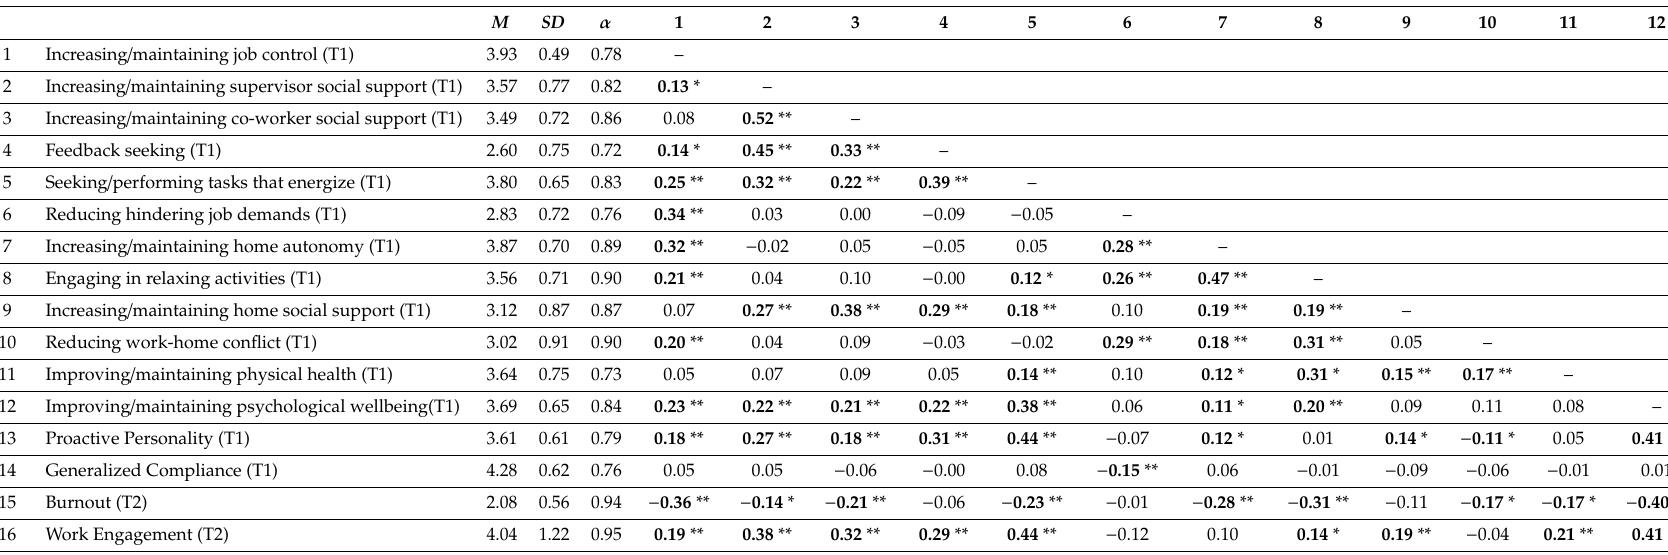
Table 3. Means, Standard Deviations, Cronbach’s alphas, and Correlations between Proactive Burnout Prevention Behaviors and Proactive Personality, Generalized Compliance, Burnout, and Work